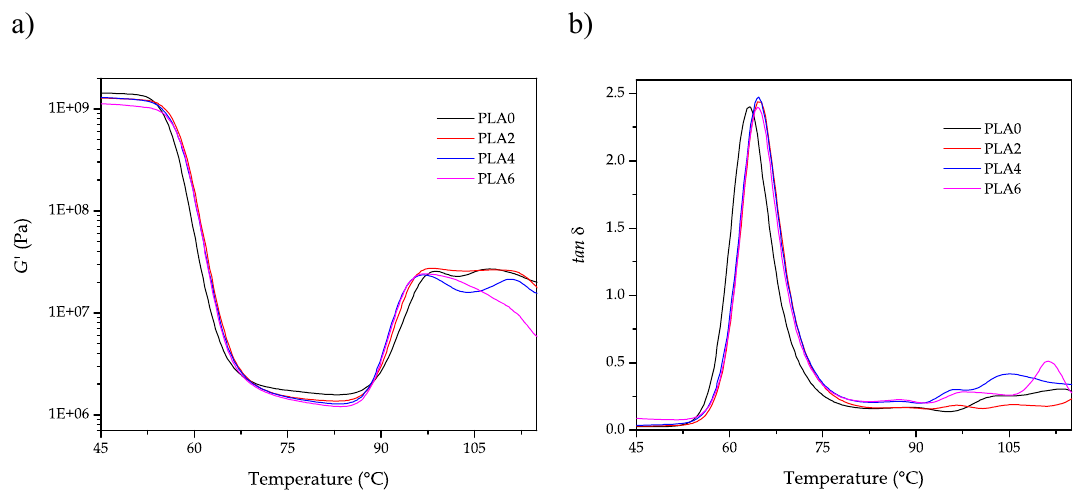
Figure 8. Evolution as a function of temperature of the ( a ) storage modulus ( G’ ) and ( b ) dynamic damping factor ( tan δ ) of the injection-molded polylactide (PLA) pieces subjected to different reprocessing cycles.